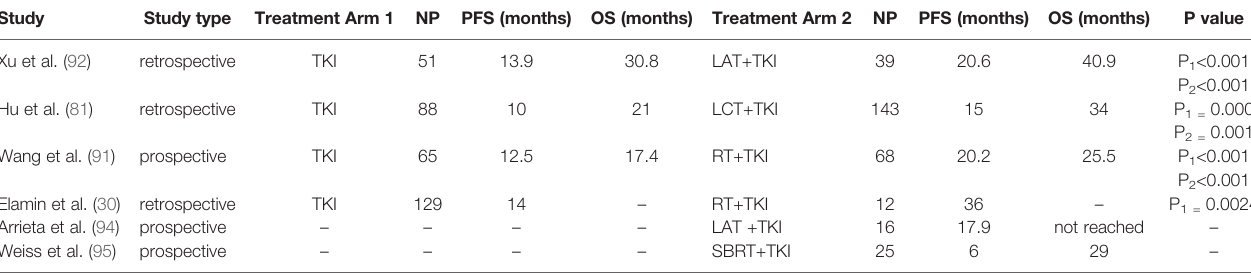
TABLE 3 | Selected studies of RT or SBRT treatment for oligoprogressive oncogene-driven NSCLC.